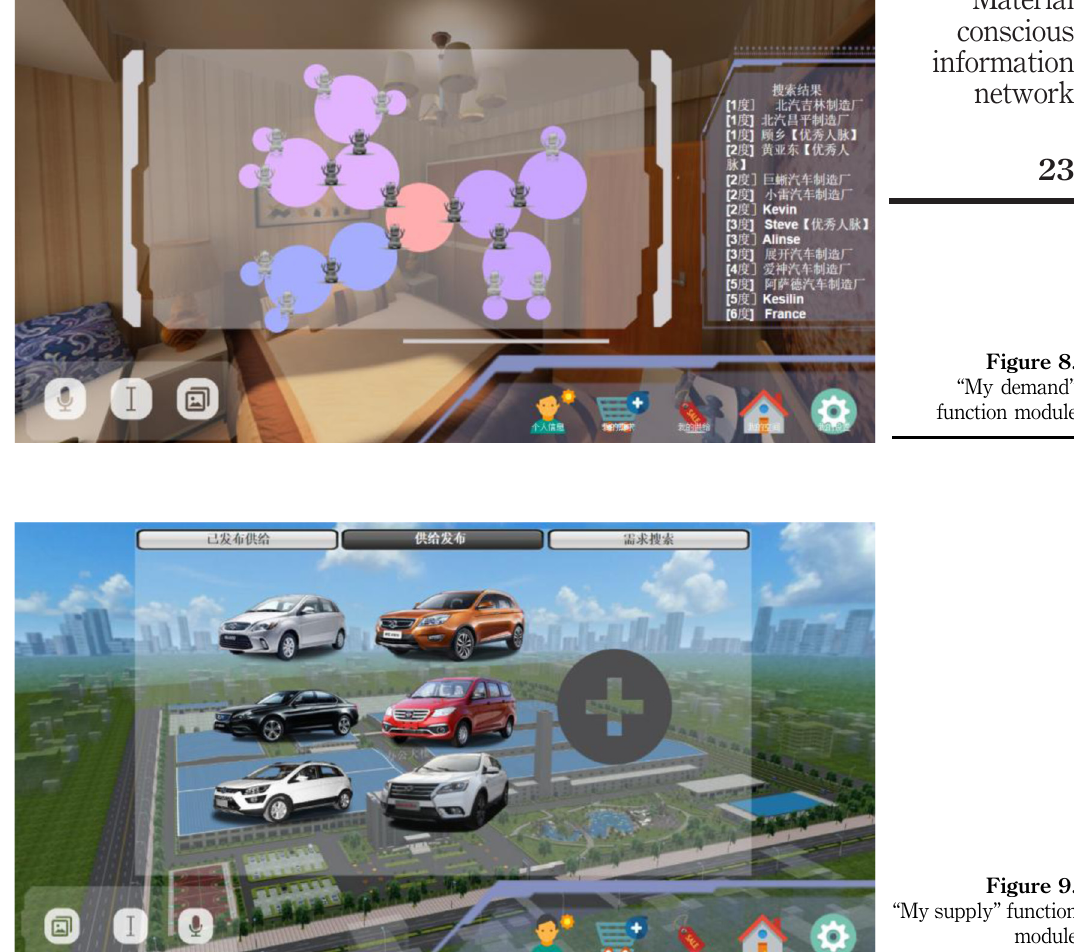
Figure 9. “ My supply ” function module